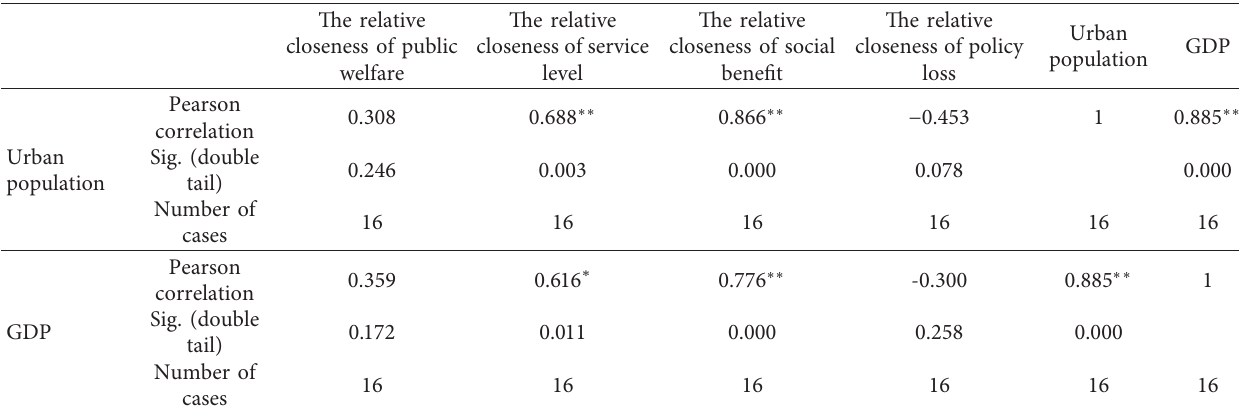
Table 4: Correlation analysis